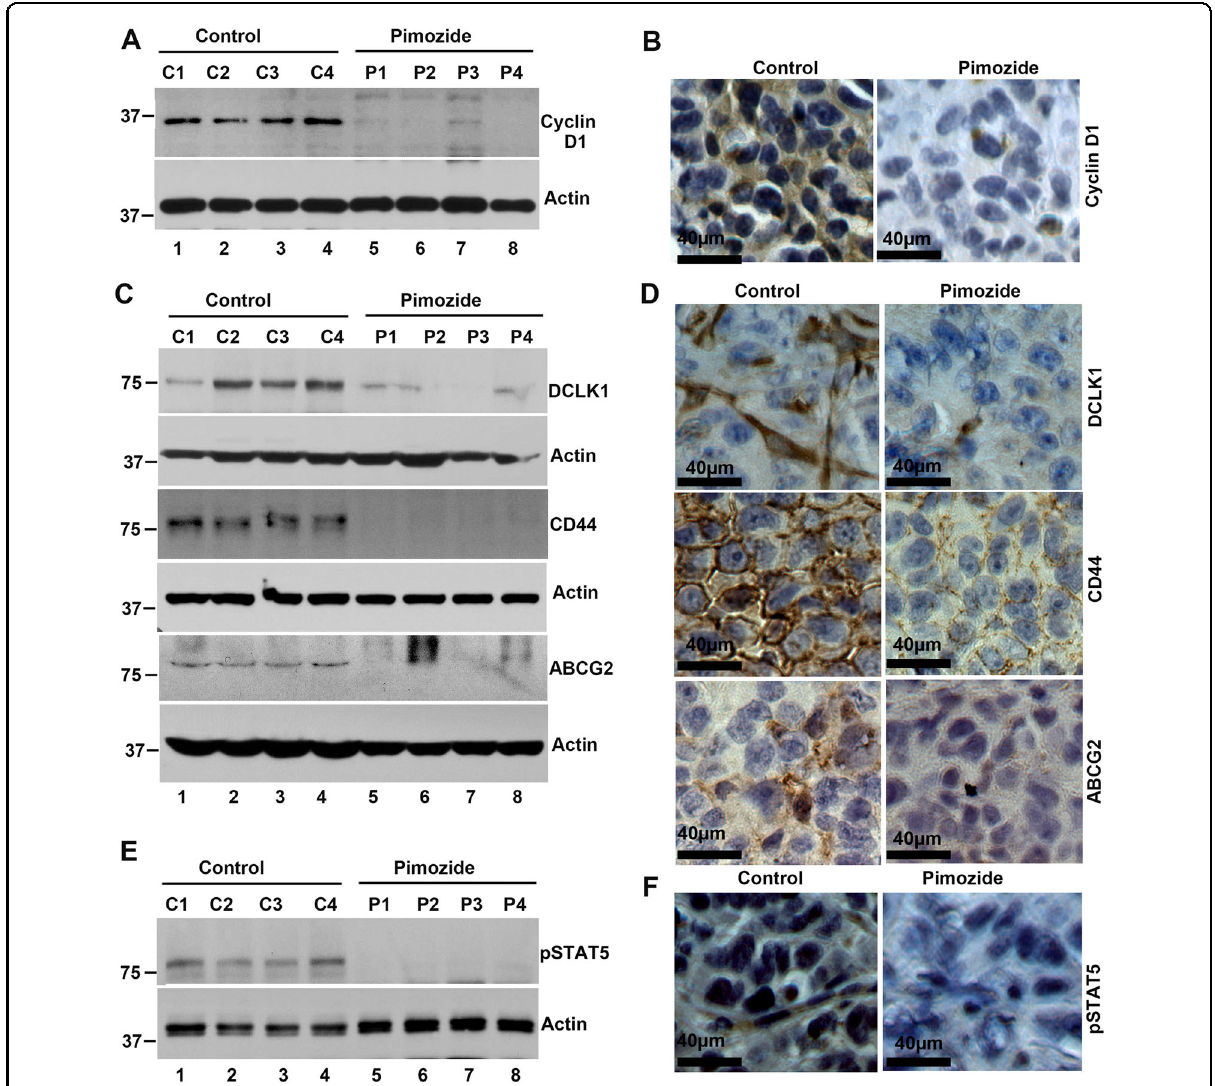
Fig. 7 Pimozide inhibits cyclin D1, cancer stem cell markers, and STAT5 signaling proteins in tumor xenograft tissues. a Western blot (C1, C2, C3, C4 are control tumor xenograft tissues and P1, P2, P3, P4 are pimozide treated tumor xenograft tissues) and b immunohistochemistry analyses showed that tissue lysates from pimozide treated animals have signi fi cantly lower levels of cyclin D1 expression. Scale bars represent 40 μ m. c Western blot (C1, C2, C3, C4 are control tumor xenograft tissues and P1, P2, P3, P4 are pimozide treated tumor xenograft tissues) and d immunohistochemistry analyses showed that tissue lysates from pimozide treated animals have signi fi cantly lower expression levels of cancer stem cell markers DCLK1, CD44 and ABCG2. Scale bars represent 40 μ m. e Western blot (C1, C2, C3, C4 are control tumor xenograft tissues and P1, P2, P3, P4 are pimozide treated tumor xenograft tissues) and f immunohistochemistry analyses showed that tissue lysates from Pimozide treated tumor tissues as signi fi cantly reduced the phosphorylation of STAT5. Scale bars represent 40 μ